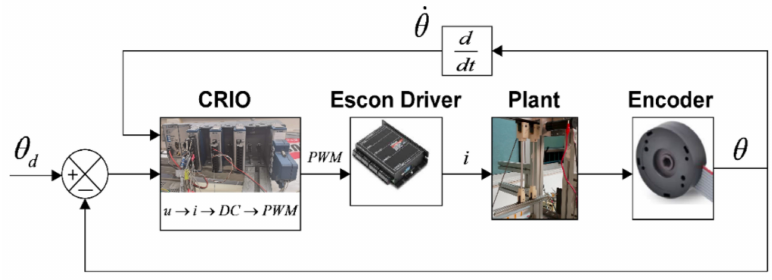
Figure A3. Real-time block diagram representation for the closed loop.